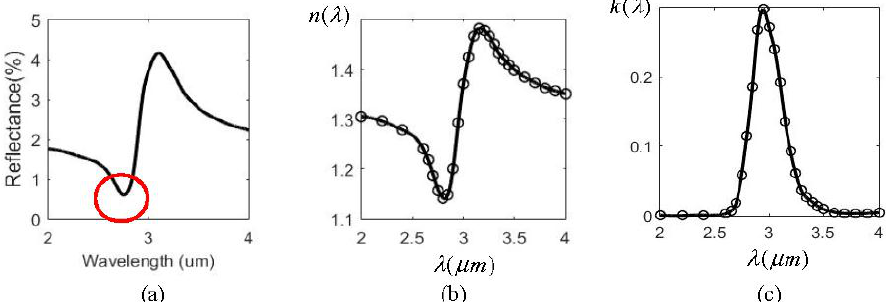
Figure 1. ( a ) Water reflectance in the infrared region (2–4 µm); ( b ) The refraction index n of water versus wavelength; ( c ) The extinction coefficient k of water versus wavelength.